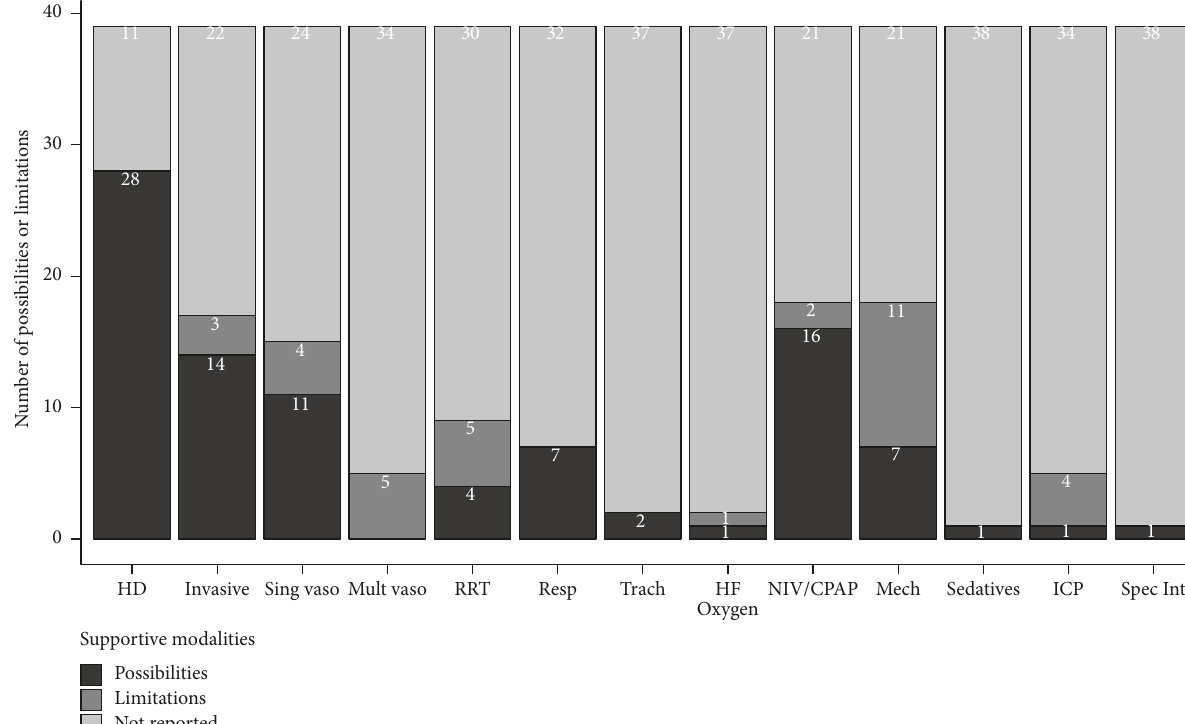
Figure 4: Possibilities and limitations of Intermediate Care Units. This chart shows that Intermediate Care Units always provided haemodynamicmonitoringandrespiratorysupport,whilecommonlimitationsweremechanicalventilation,multiplevasoactivemedications, renal replacement therapy, and intracranial pressure management. HD = hemodynamic monitoring; Invasive = invasive monitoring; Sing vaso = single vasoactive medication; Mult vaso = multiple vasoactive medications; RRT = renal replacement therapy; Resp = respiratory support; Trach = tracheostomy care; HF Oxygen = high-flow oxygen therapy; NIV/CPAP = noninvasive ventilation/continuous positive airway pressure; Mech = mechanical ventilation (ventilation of weaning); ICP = intracranial pressure measurement; Spec Int = specific